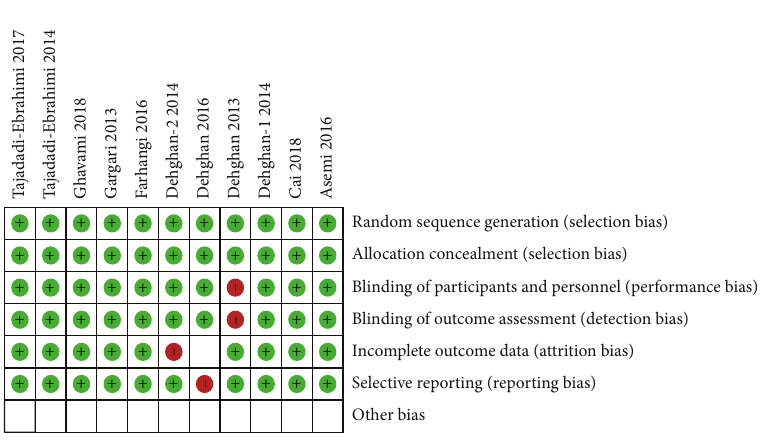
Figure 2: Risk of bias summary for included